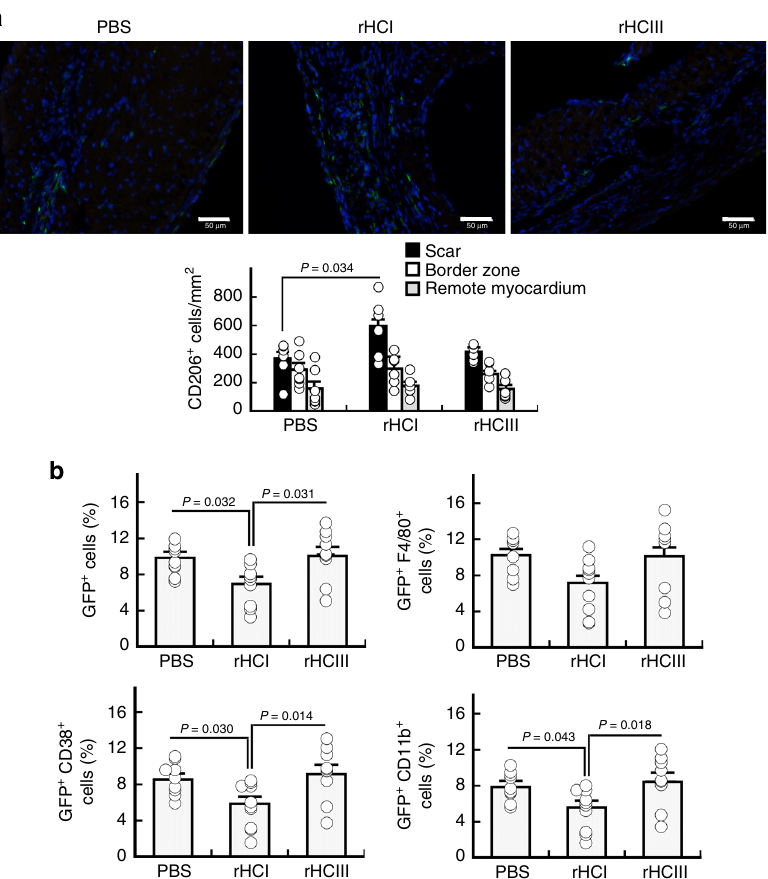
Fig. 5 rHC matrix treatment alters bone marrow cell and macrophage response. a Immunohistochemistry analysis and quanti fi cation of the number of CD206 + macrophages (per mm 2 ) in the scar, border zone and remote myocardium of MI hearts treated with PBS, rHCI, or rHCIII. CD206, green; DAPI, blue ( n = 6 – 7). b Flow-cytometry analysis for the number of GFP + , GFP + F4/80 + , GFP + CD38 + , and GFP + CD11b + cells recruited from the bone marrow to the left ventricle of Cxcr3-EGFP MI mice 2 days after PBS, rHCI, or rHCIII treatment ( n = 9 – 10). P -values were determined by one-way ANOVA using Holm ’ s multiple comparison. The data are presented as the mean ± SEM. Source data are provided as a Source Data fi le. For a , b , n indicates the number of mice per